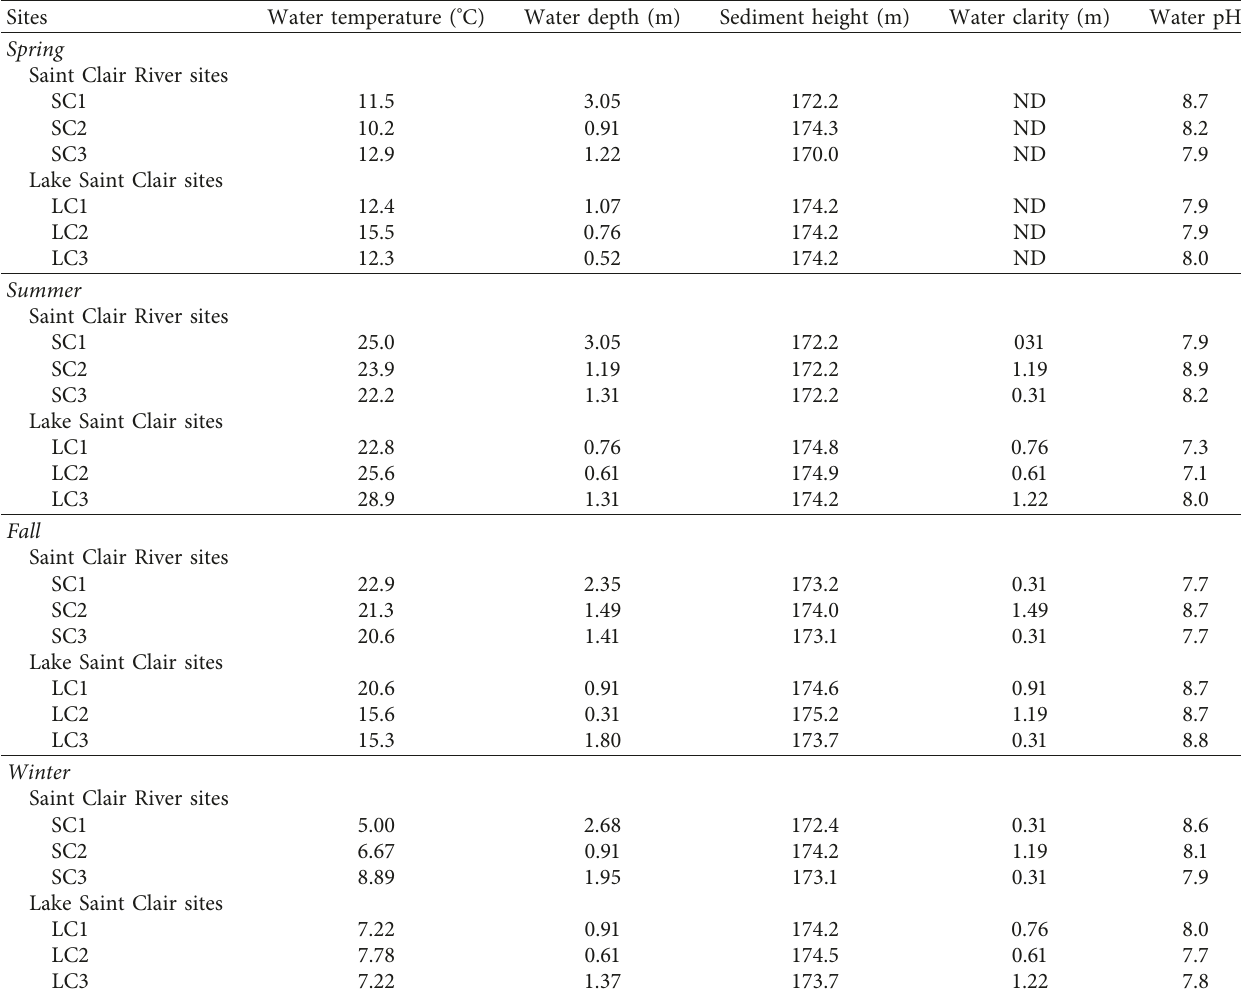
Table 1: Water temperature, water depth, sediment height, water clarity, and water